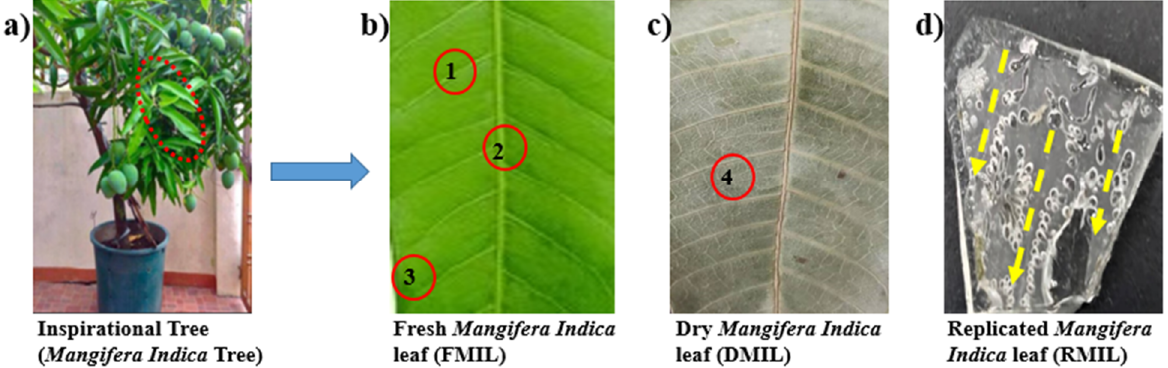
Figure 1. Photograph images ( a ) inspired Mangifera Indica tree (MIT) ( b ) Fresh Mangifera Indica leaf (FMIL); red cycle 1—Secondary vein, red cycle 2—Primary vein, red cycle 3—Curvature ( c ) Dry Mangifera Indica leaf (DMIL); red cycle 4—microscales, and ( d ) Replicated Mangifera Indica leaf (RMIL)-Yellow dot lines represent droplet drainage paths .